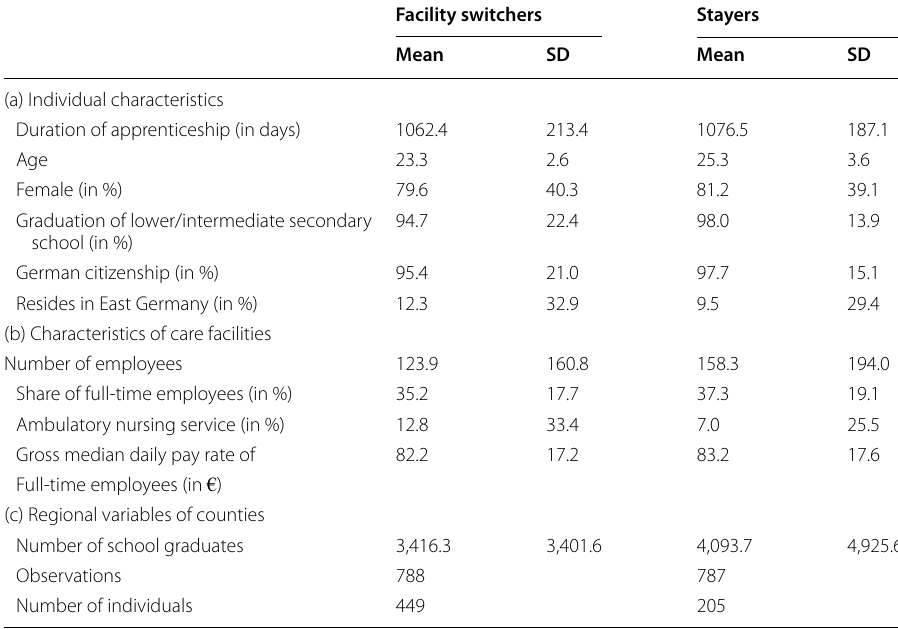
The table displays means and standard deviations (SD) of characteristics of graduates, care facilities, and counties. Facility switchers are graduates who left the training facility sometime after completing apprenticeship training, while stayers stick to the training